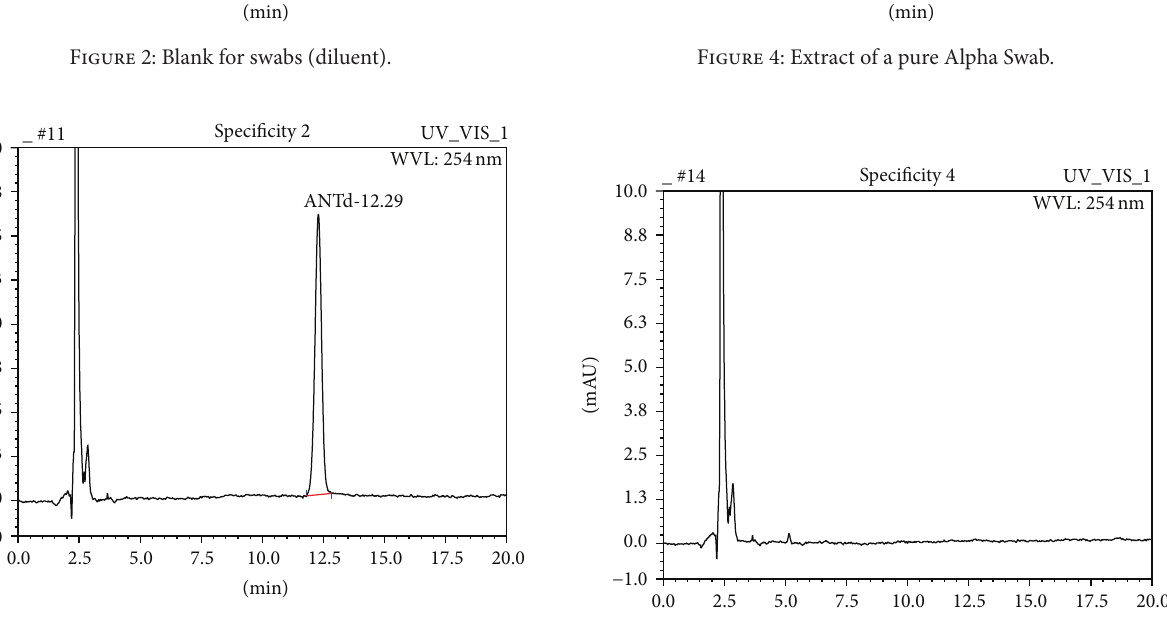
Figure 3: Reference solution (2 𝜇 g/mL).